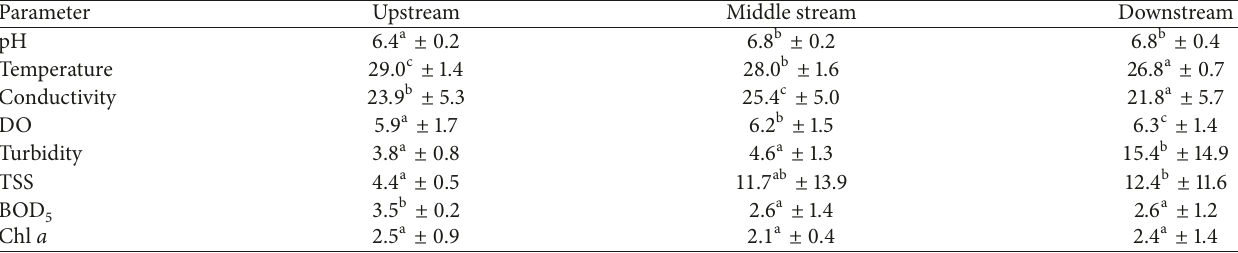
Table 2: Means and standard deviations of the physicochemical characteristics of the downstream river of Batang